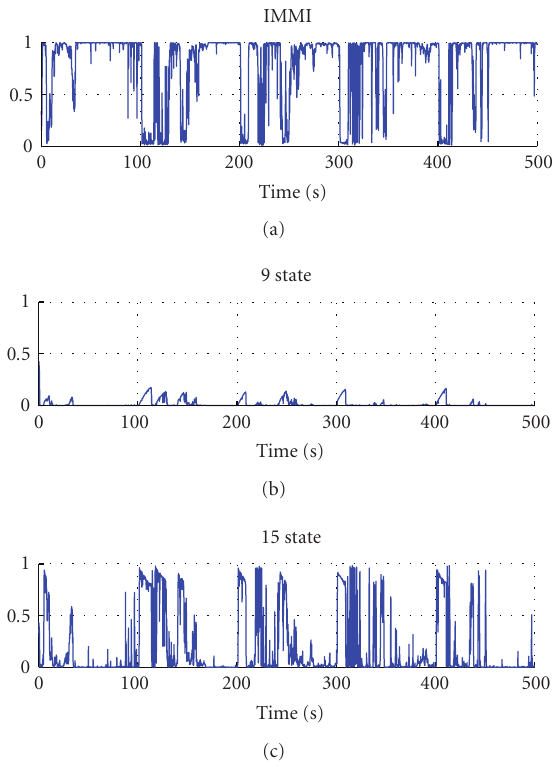
Figure 16: Posterior probability of the EKFs structures in EIMMAE